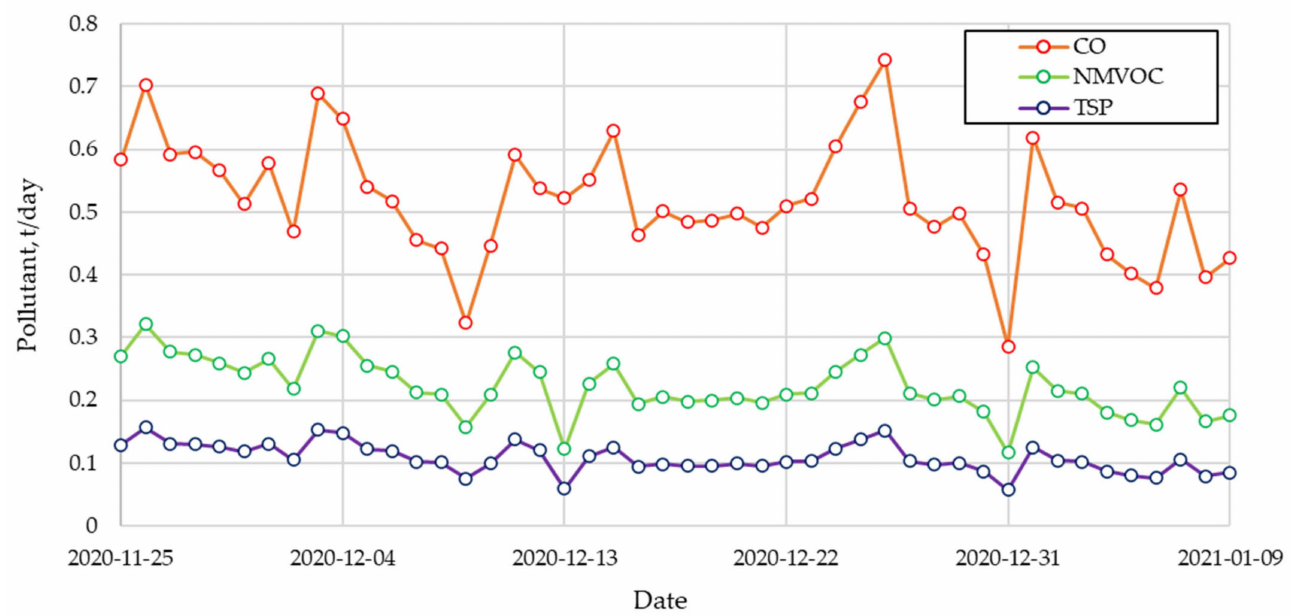
Figure 5. Summed CO, NMVOC and TSP emissions for each individual day.